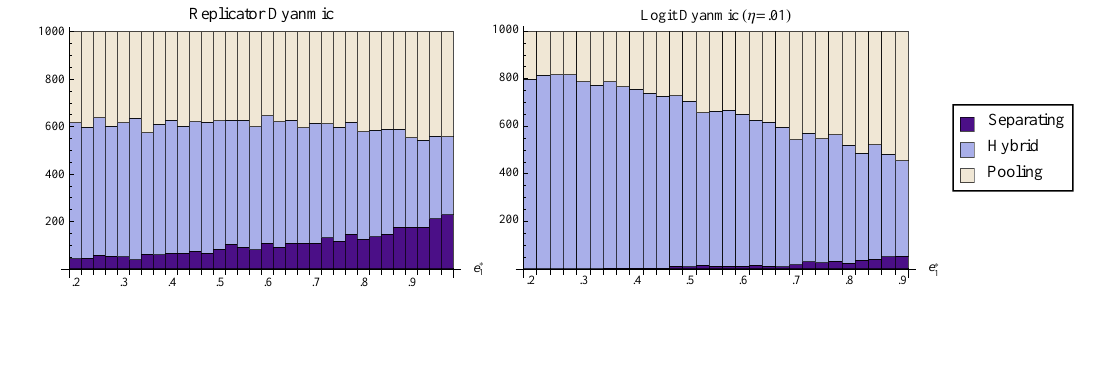
Figure 7. The number of randomly chosen initial conditions that converged to pooling, separating, and the hybrid face under both the replicator dynamic and the logit dynamic with η = . 01 . e ∗ is is held fixed at 1 . 025 while e ∗ 1 2